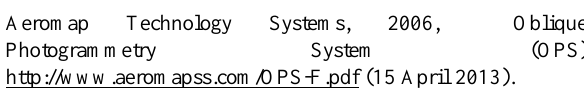
entrances and openings.